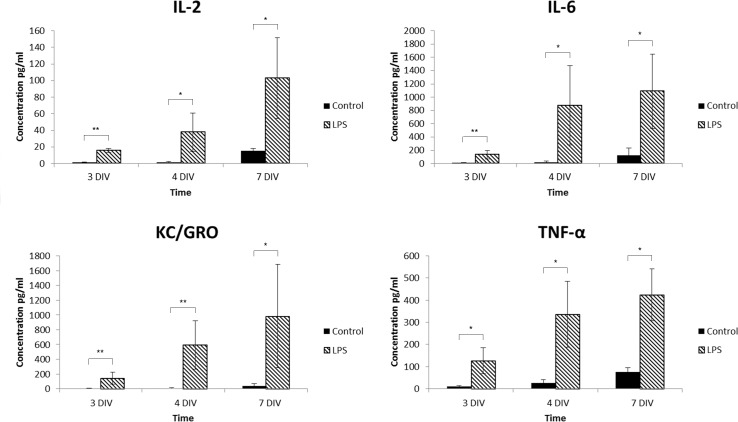
Cytokine release profiles.In collected conditioned media at 3, 4 and 7 DIV, the immune mediator release profile was analyzed using a biochemical assay. Ten well-described cytokines were included; interferon gamma (IFN-γ), interleukin-1β (IL-1β), interleukin-2 (IL-2), interleukin-4 (IL-4), interleukin-5 (IL-5), interleukin-6 (IL-6), interleukin-10 (IL-10), interleukin-12p70 (IL-12p70), KC/GRO and tumour necrosis factor alpha (TNF-α). No detectable levels of release of any of the mediators analyzed were found in controls at any of the time-points included. However, after LPS stimulation at 3 DIV, a significant increase of four of the mediators was found, i.e. IL-2, IL-6, KC/GRO and TNF-α. Note that the content of these factors further increased over time in culture to higher levels compared to at 3 DIV. Filled bar = control group, Striped bar = LPS group. ANOVA analysis was performed for comparison between the LPS treated group and the control groups. Data are expressed as mean±StDev (n = 3/group), *p<0.05, **p<0.01.